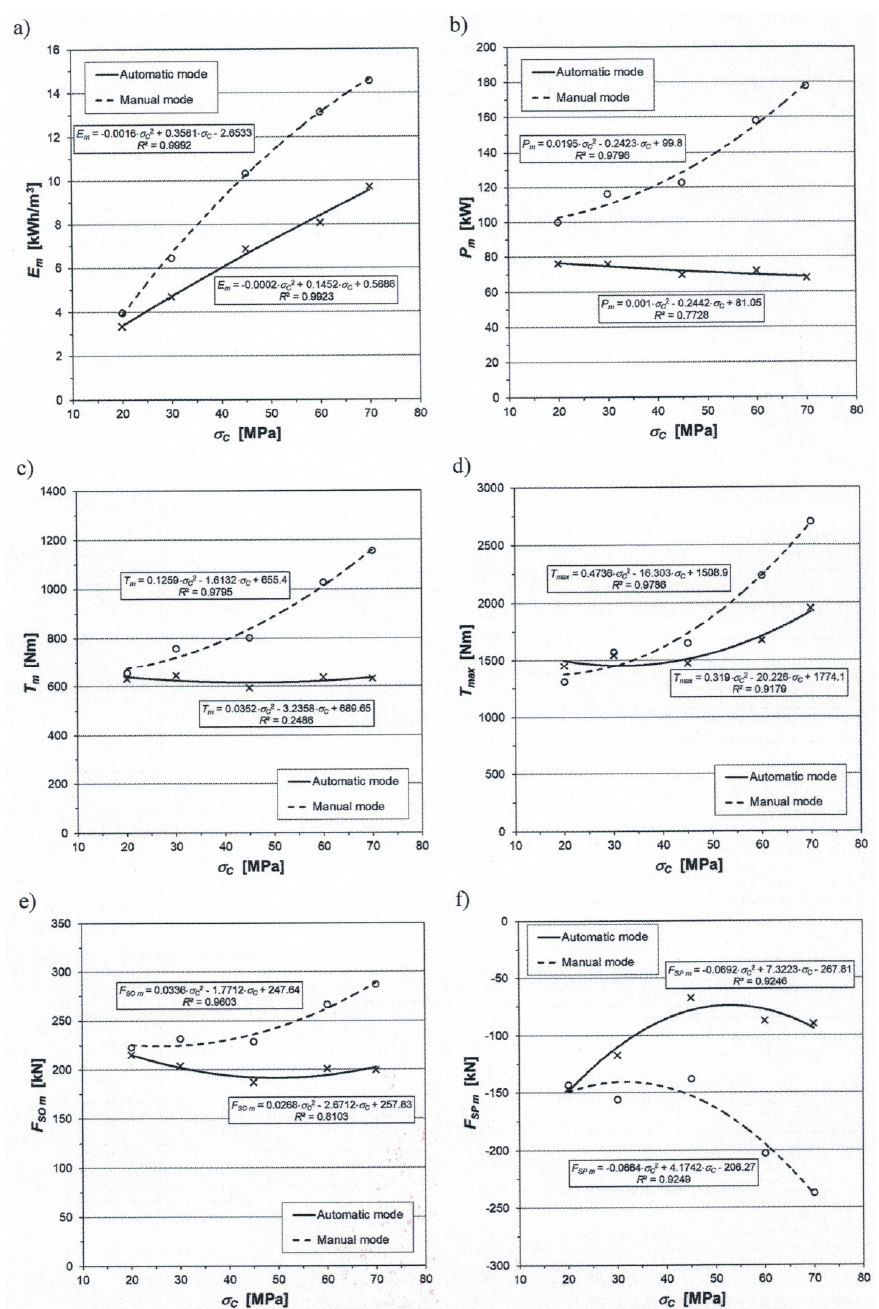
Figure 7. Comparison of the relationship: ( a ) average cutting energy consumption ( E m ), ( b ) average cutting power ( P m ), ( c ) average torque on the motor shaft in the cutting heads drive ( T m ), ( d ) peak torque on the motor shaft in the cutting heads drive ( T max ), ( e ) average load of the boom swinging actuator ( F SO m ), and ( f ) average load of the boom deflection actuators ( F SP m ) from the uniaxial compressive strength of the rock being mined for simulated cutting in automatic control mode (solid lines) and manual control mode (dashed lines).